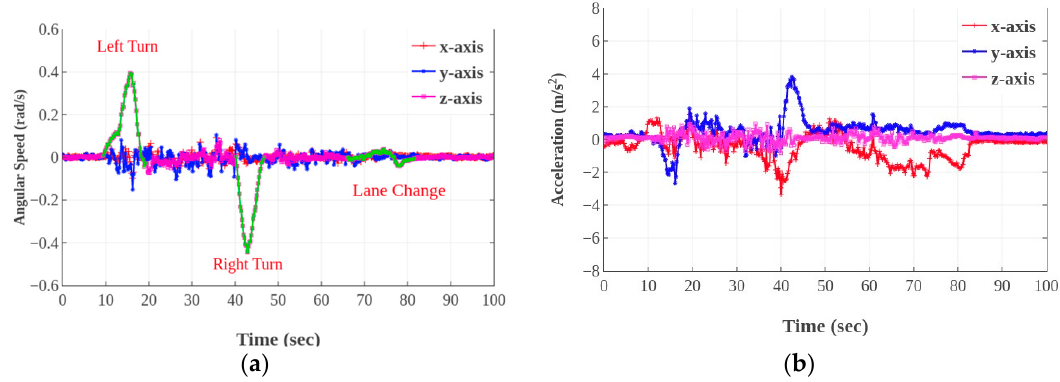
Figure 8. Patterns of lane change and turning, angular speed ( a ); acceleration ( b ).